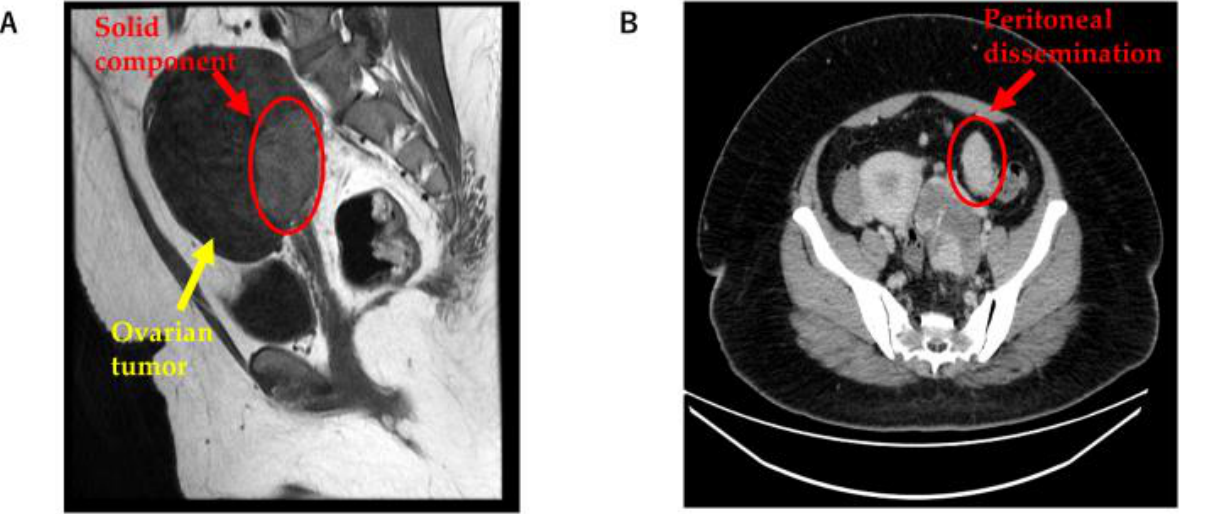
Figure 1. ( A ) MRI showing a solid component in the left ovarian tumor; and ( B ) CT showing peritoneal dissemination. MRI: magnetic resonance imaging; CT: computed tomography.